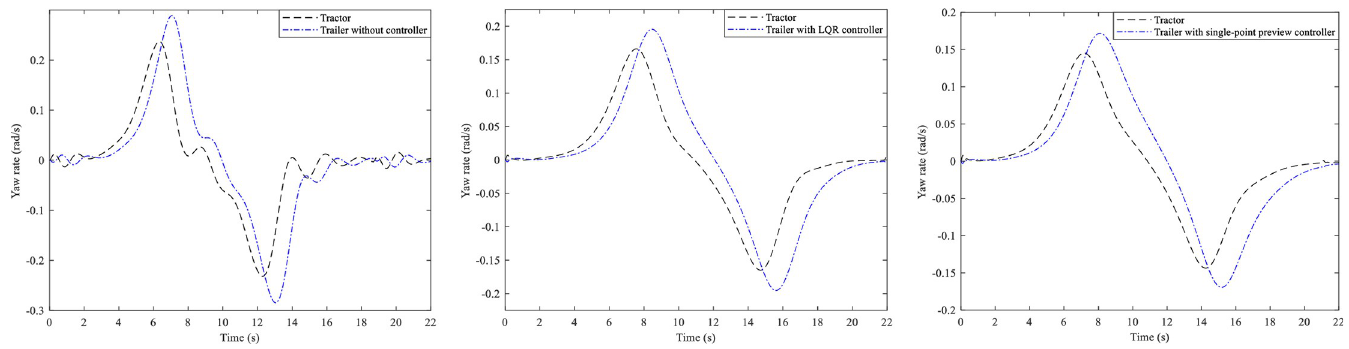
Fig 7. Yaw rate curves. (A) Trailer without controller. (B) Trailer with LQR controller. (C) Trailer with single-point preview controller.